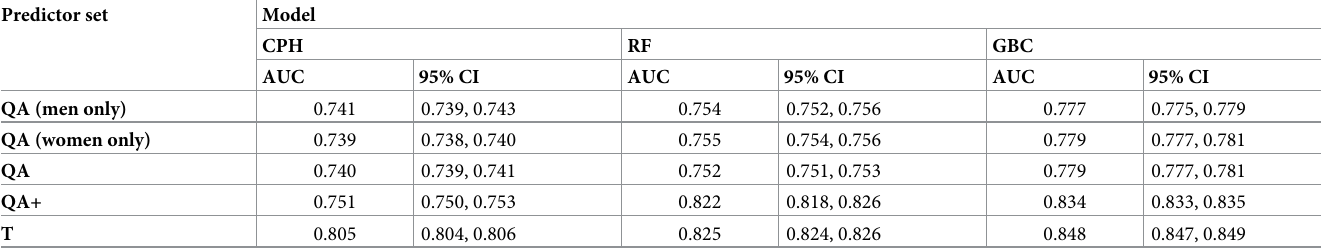
Table 3. Cross-validated model discrimination for different predictor sets and modelling techniques: Derivation cohort. Predictor set